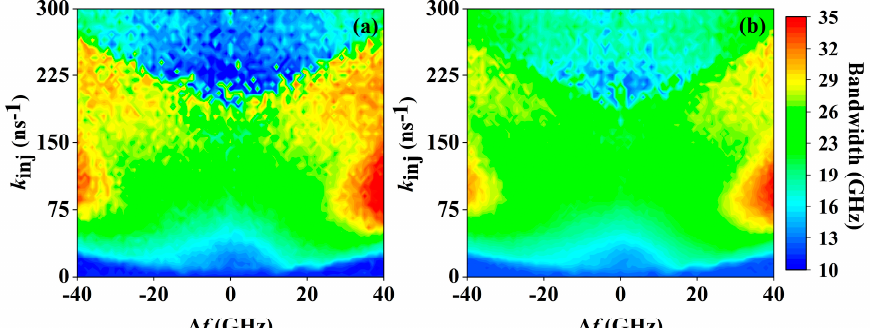
Figure 8. Polarization chaos bandwidth of ( a ) XP mode and ( b ) YP mode of VCSEL1 in parallel injection as a function of the coupling coefficient k inj and frequency detuning Δ f .